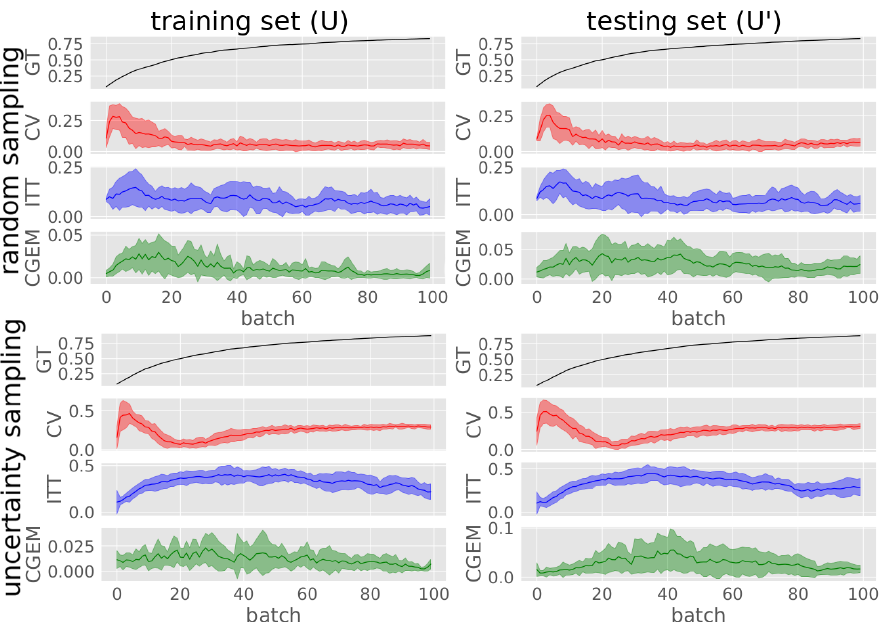
Figure A2. Ground-truth accuracy and accuracy estimation errors with standard deviation of tested approaches for the GLVQ classifier trained on the OUTDOOR data set for both random sampling and uncertainty sampling and both train and test